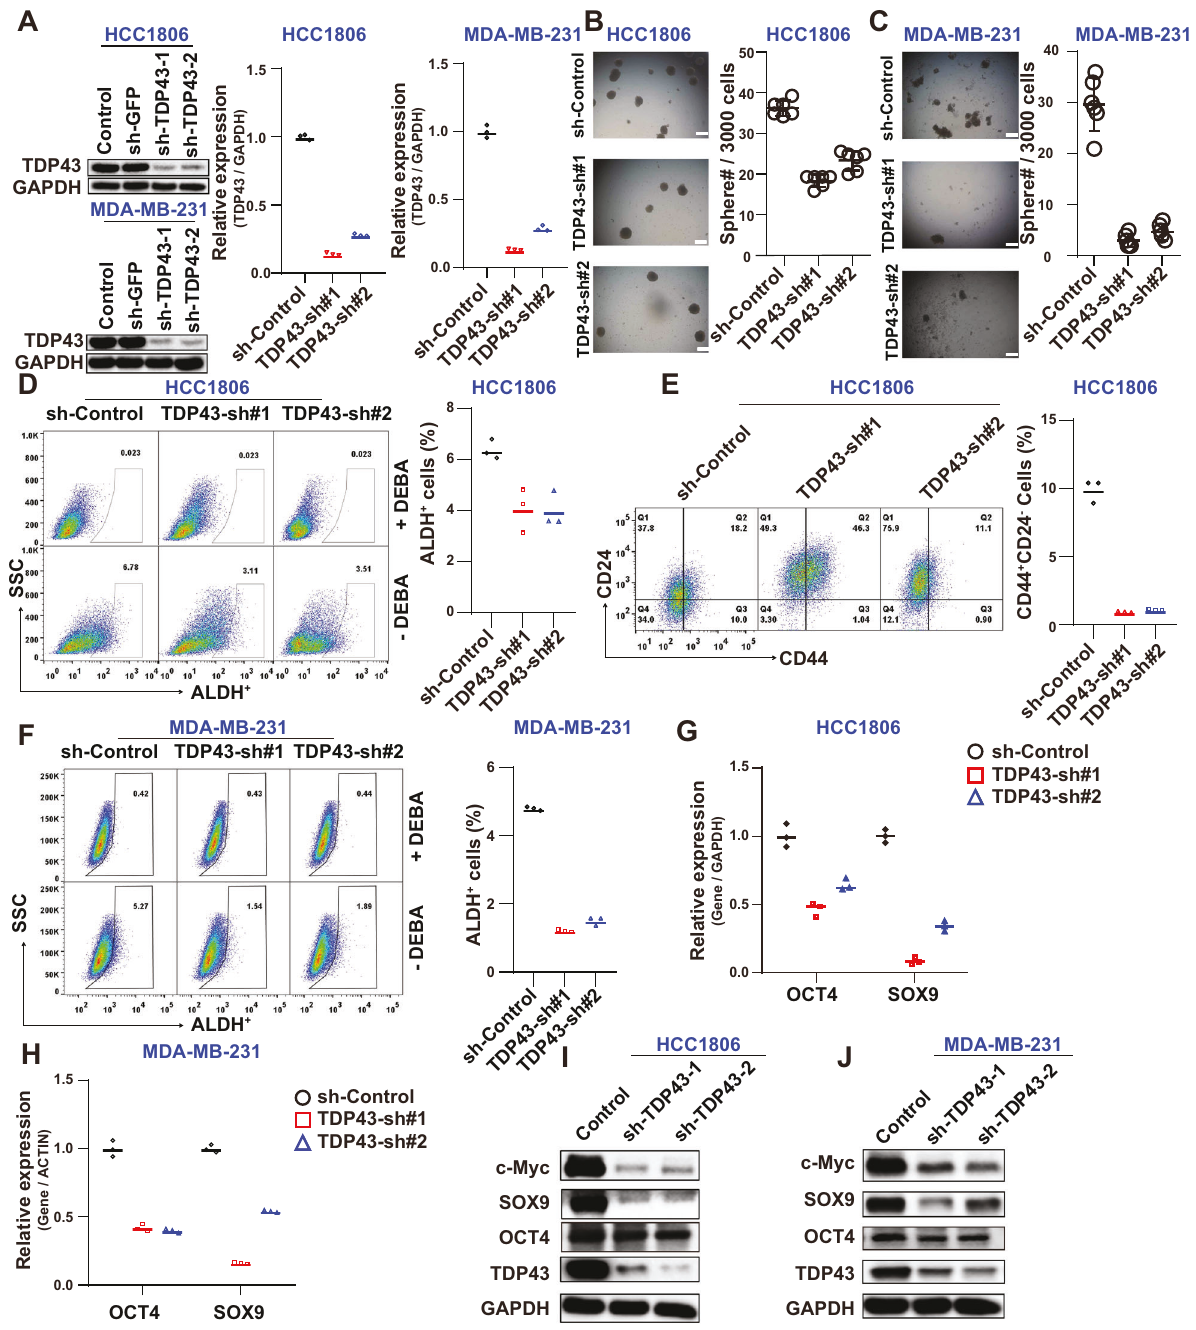
Fig. 1 Loss of TDP43 inhibits stemness of BCSCs. A Western blot (left) and qPCR (right) showing the knockdown (KD) ef fi ciency in MDA-MB- 231 and HCC1806 cells after TDP43 KD. B , C Calculation of number of tumorspheres in MDA-MB-231 and HCC1806 cells upon TDP43 KD. ALDH cell fraction ( D ) and CD24 low CD44 high population ( E ) in HCC1806 cells, and ALDH ratios in MDA-MB-231 cells ( F ) by fl ow cytometry analysis. G , H Expression changes in stemness markers. I , J KD ef fi ciency and stemness genes at protein level. Data are means ± markedly suppressed in both cell lines (Fig. S3E, F). The qPCR PCR. Considering that CD44v splice isoforms show very diverse in results were validated using semi-quantitative RT-PCR, which HCC1937 cells (Figs. 4D and S3G), which may lead to ampli fi cation showed consistent results (Figs. 4D and S3G). failure due to multiple PCR peaks during quantitative PCR, we In addition to loss-of-function, we OE SRSF3 to observe any performed the quantitative PCRs of CD44 AS in MDA-MB-231 and changes in CD44v (Fig. S3H). Using the same approach as in Fig. 2, HCC1806 cells. Results showed that the CD44v/CD44s ratio was we examined the CD44v/CD44s ratio in the MDA-MB-231 and signi fi cantly decreased following SRSF3 KD (Fig. 4B, C), but CD44 HCC1806 cells. Exogenous expression of SRSF3 induced a signi fi cant (total) expression did not change in the MDA-MB-231 and increase in CD44v abundance in both cell lines (Fig. 4E, F), while HCC1806 cells (Fig. S3D). The CD44v6-8 and CD44v8-10 expression CD44 (total) transcription did not change upon SRSF3 OE (Fig. 4G), levels were also detected after KD of SRSF3 and were found to be